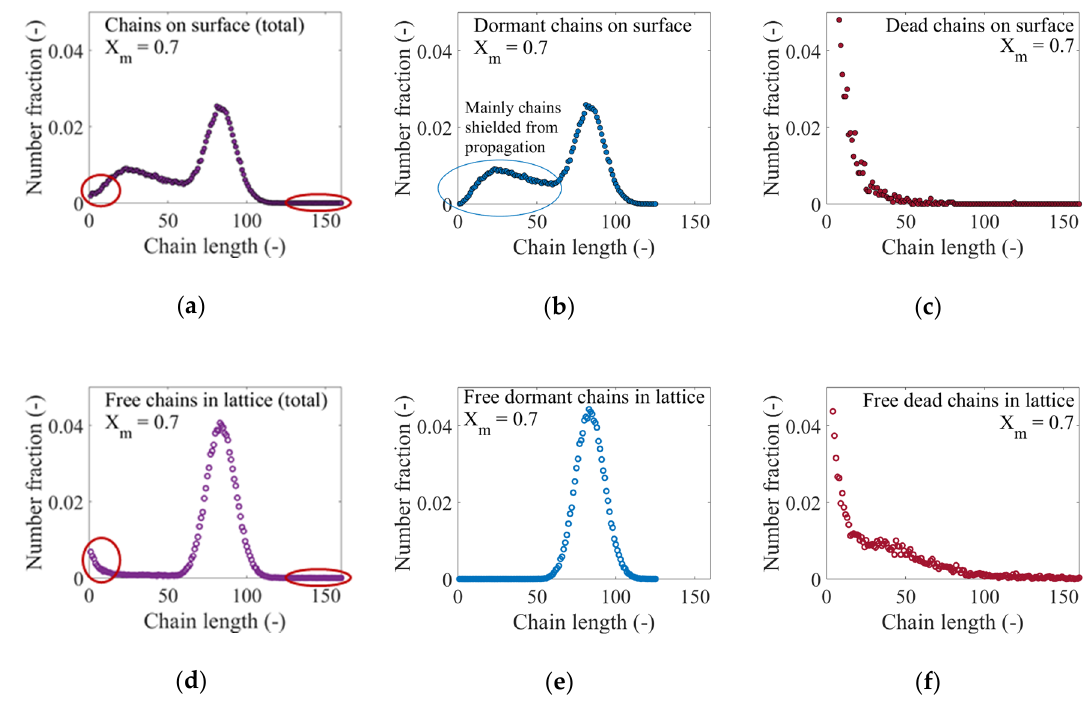
Figure 6. Top: Number chain length distribution of ( a ) all surface-tethered polymer chains (black-contoured full purple circles), ( b ) surface-tethered dormant chains (black-contoured full blue circles) and ( c ) surface-tethered dead polymer chains (black-contoured full red circles). Bottom: Number chain length distribution of ( d ) all free polymer chains (purple-contoured empty circles), ( e ) free dormant chains (blue-contoured empty circles) and ( f ) free dead polymer chains (red-contoured empty circles). In ( a , d ) the regions circled in red represent the contributions of dead polymer chains to the CLD of the total polymer species in both phases. These distributions are obtained at a monomer conversion X m = 0.7. Same (reference) conditions (translational mode) as in Figure 4 and the kinetic parameters in Table 1. The evolution of these distributions as a function of monomer conversion is included in Figure S2 in Supporting Information.